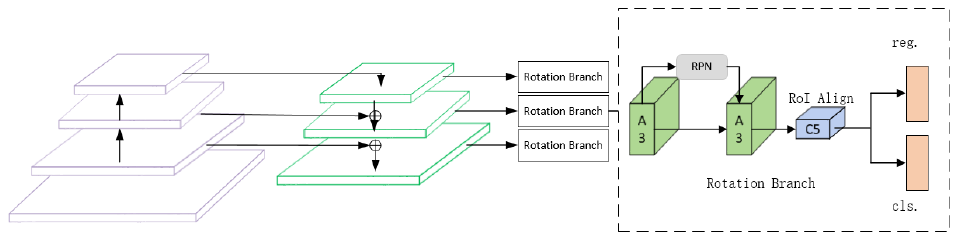
Figure 10. The network architecture of FR-O.